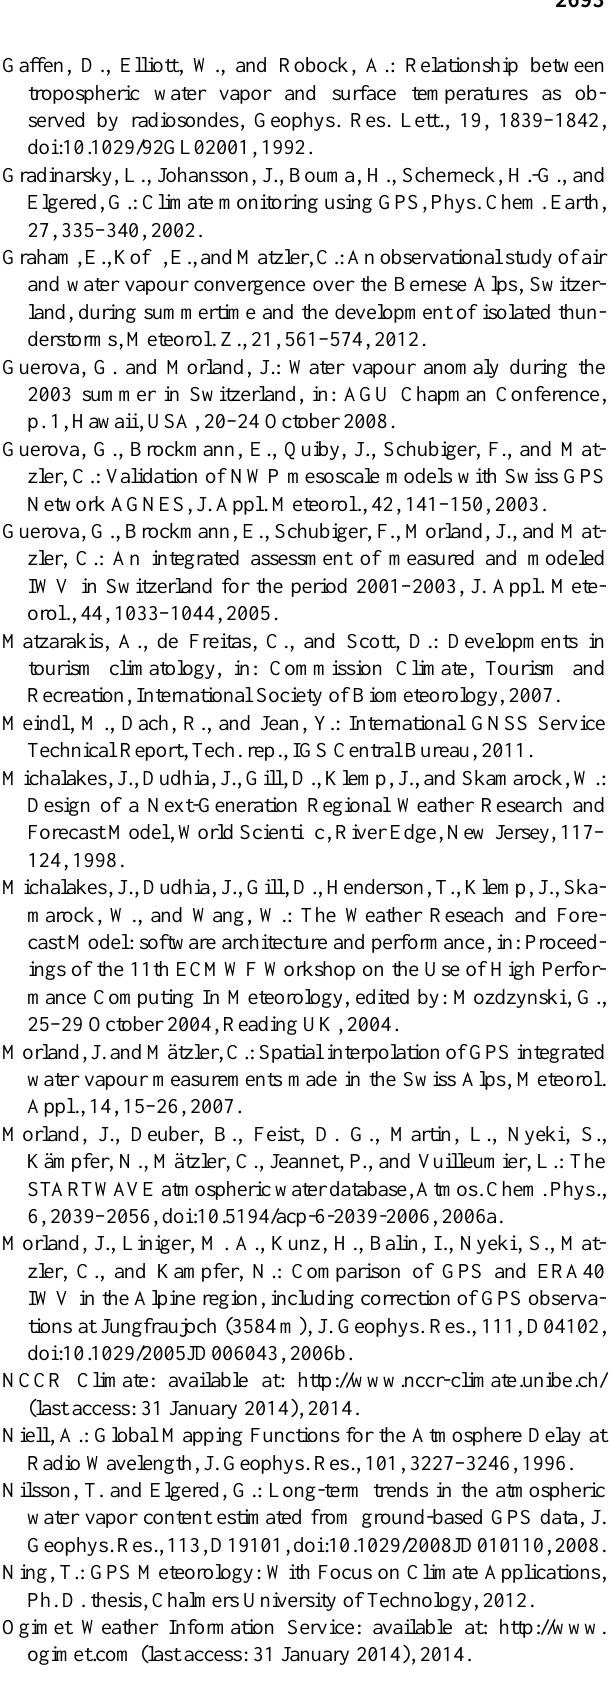
Ch. Georgiev and A. Stoycheva from the National Institute of Meteorology and Hydrology provided the Meteosat IWV plots and the detailed analysis of the weather conditions. The tropospheric products are the result of collaboration with the ZenitGEO team and Keranka